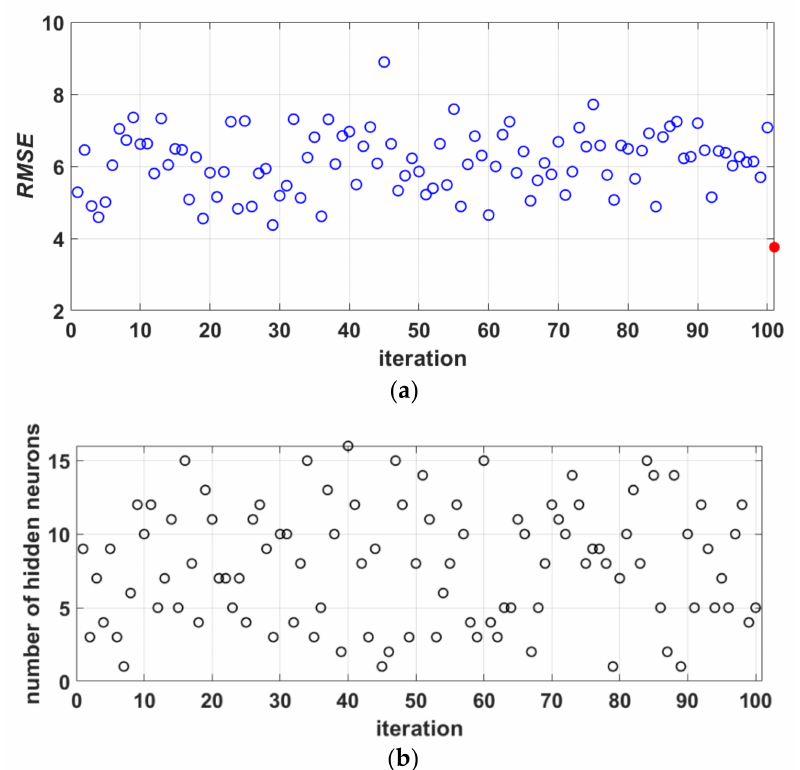
Figure 8. ( a ) RMSE value for each of the iterations and the corresponding architecture; ( b ) the optimal number of neurons in the hidden layer in each iteration.